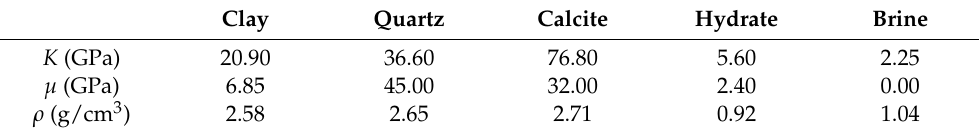
Table 1. Properties of the constituents used in rock physics modeling [37,38].